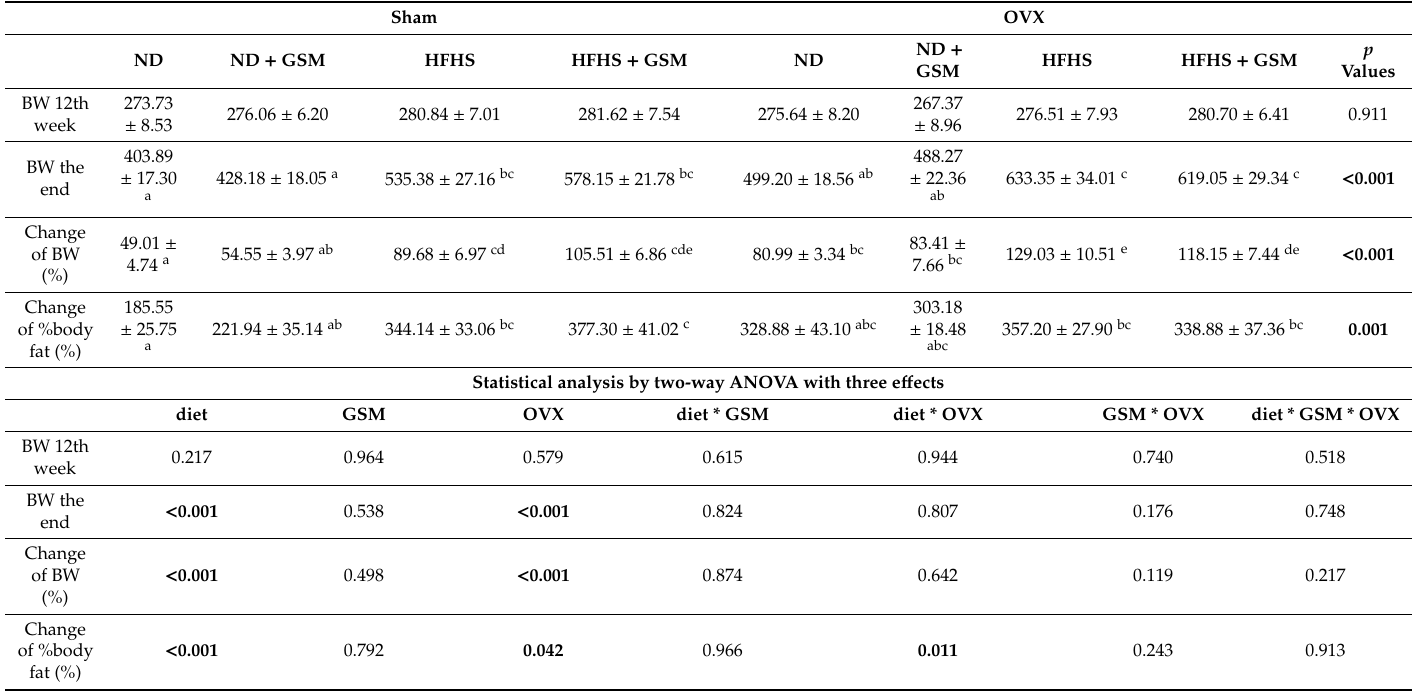
Table A1. Body composition of the rats at 48 weeks of